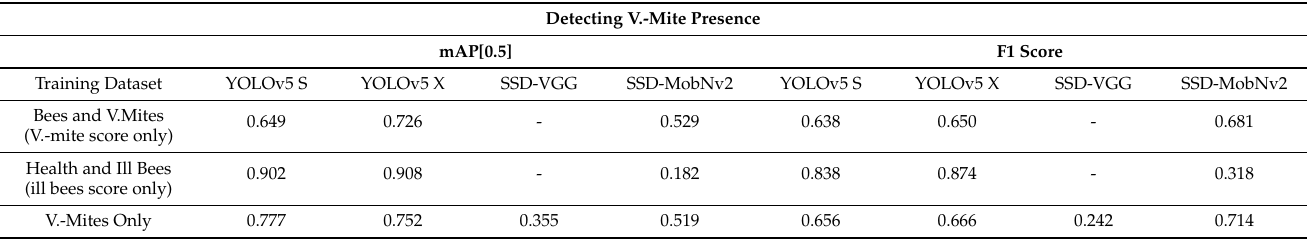
Table 8. Table shows the mAP[0.5] score at V.-mites detection (V.-mites or an infected bee) for all neural network models that we used in this